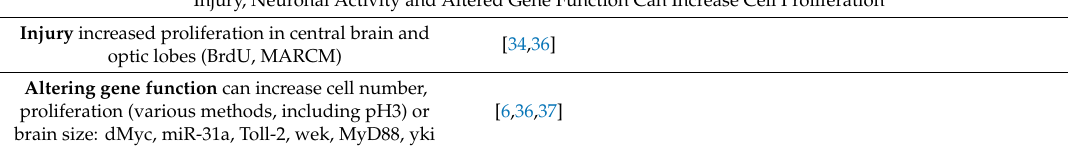
Cycling cells detected in S-phase with 3 H-Thymidine, BrdU, EdU, PCNA-GFP and FUCCI; in G1, with FUCCI; in G2, G2 / M were revealed with FUCCI, nuclear Stg-GFP and